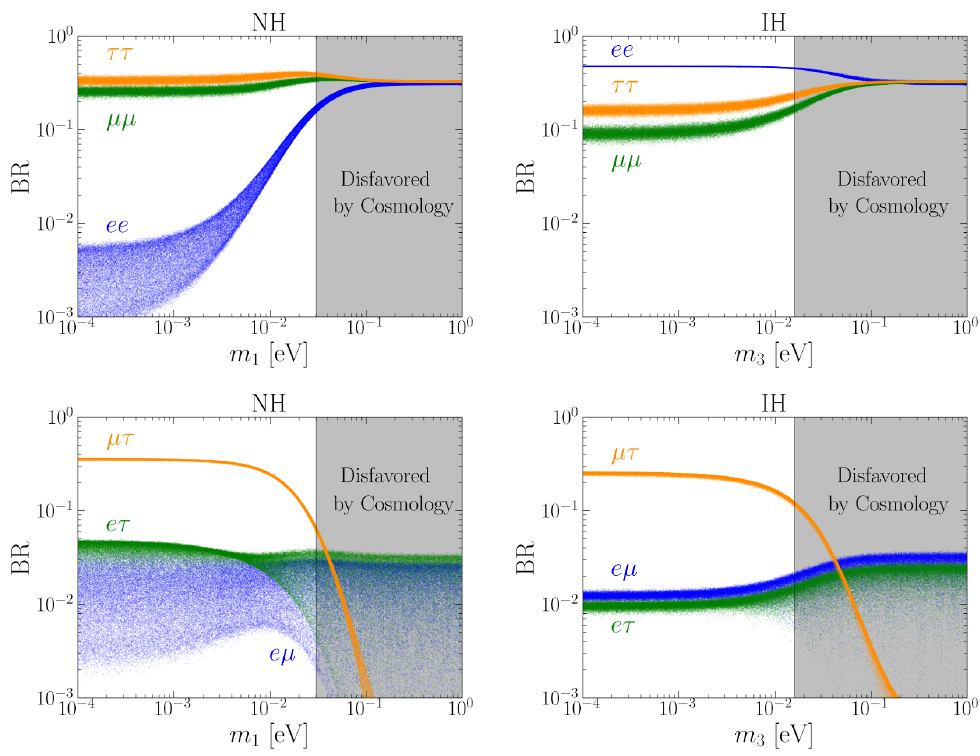
Figure 1 . Scatter plots for the branching ratios of H ++ decay into the same flavor (two upper panels) and different flavor (two lower panels) like-sign leptons versus the lowest neutrino mass for NH (two left panels) and IH (two right panels) with Φ the current limit on the lightest neutrino mass m by the Planck collaboration